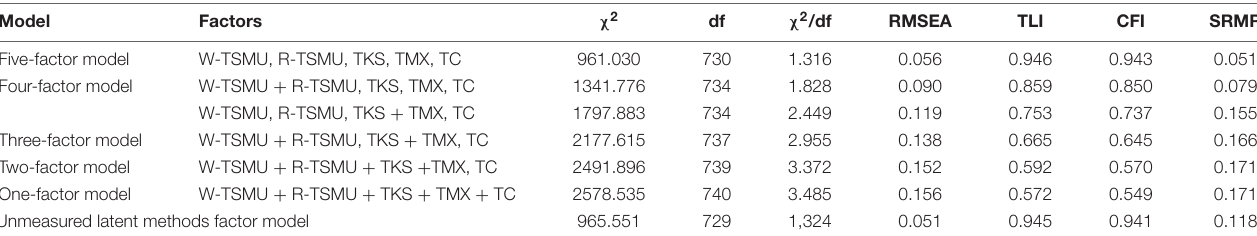
TABLE 1 | Results of confirmatory factor